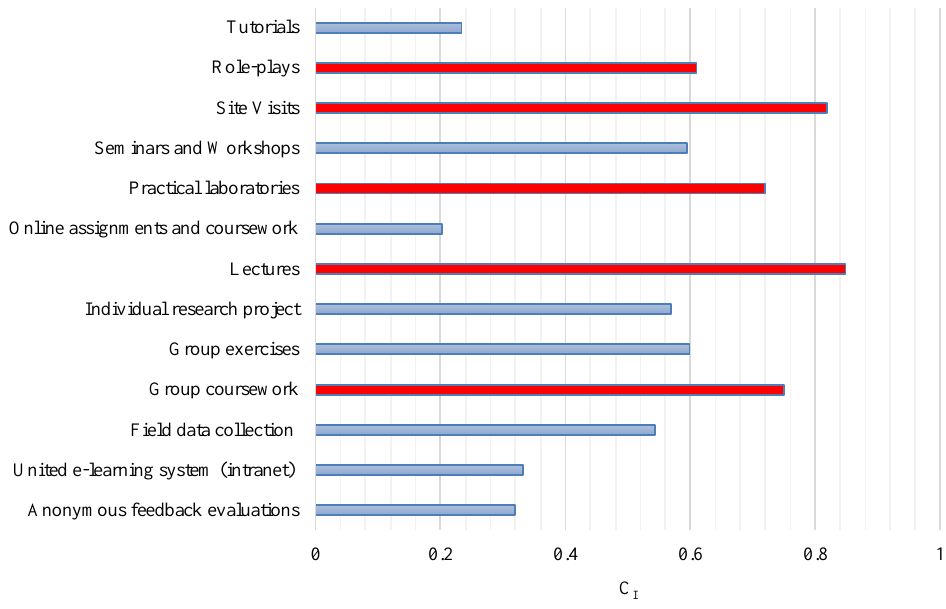
Fig. 3. Comparison of teaching methods